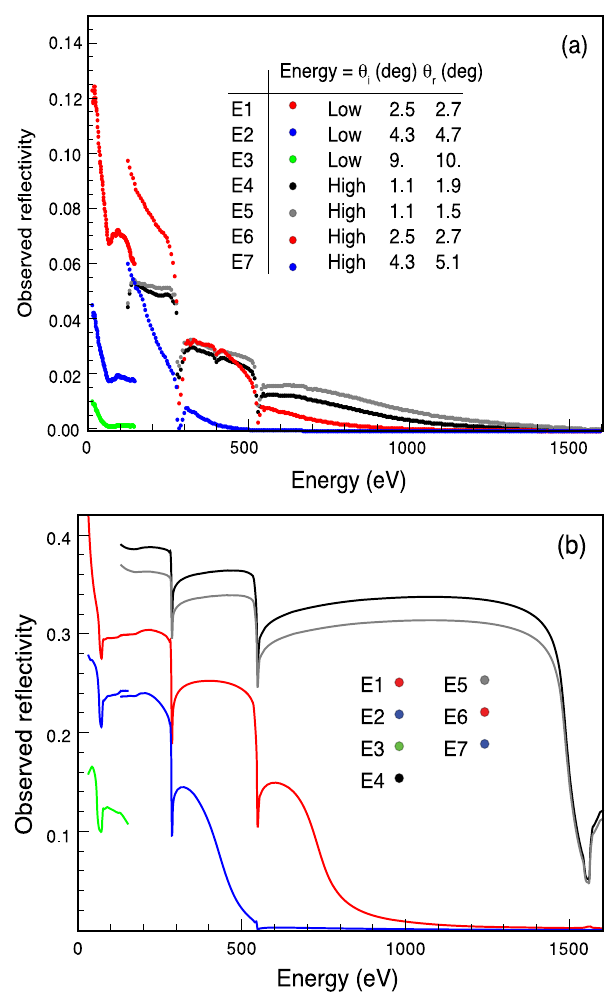
FIG. 31. Observed reflectivity, as a function of energy, alumi- num sample #1 (top), and calculated reflectivity based on scattering model (bottom).